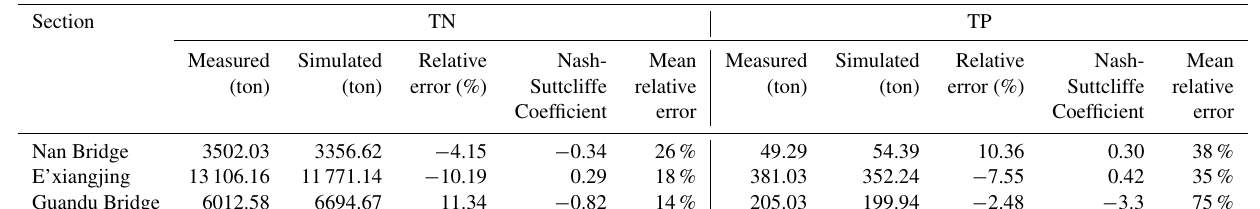
Table 6. Pollutant flux for TN and TP of controlling sections and their relative errors.